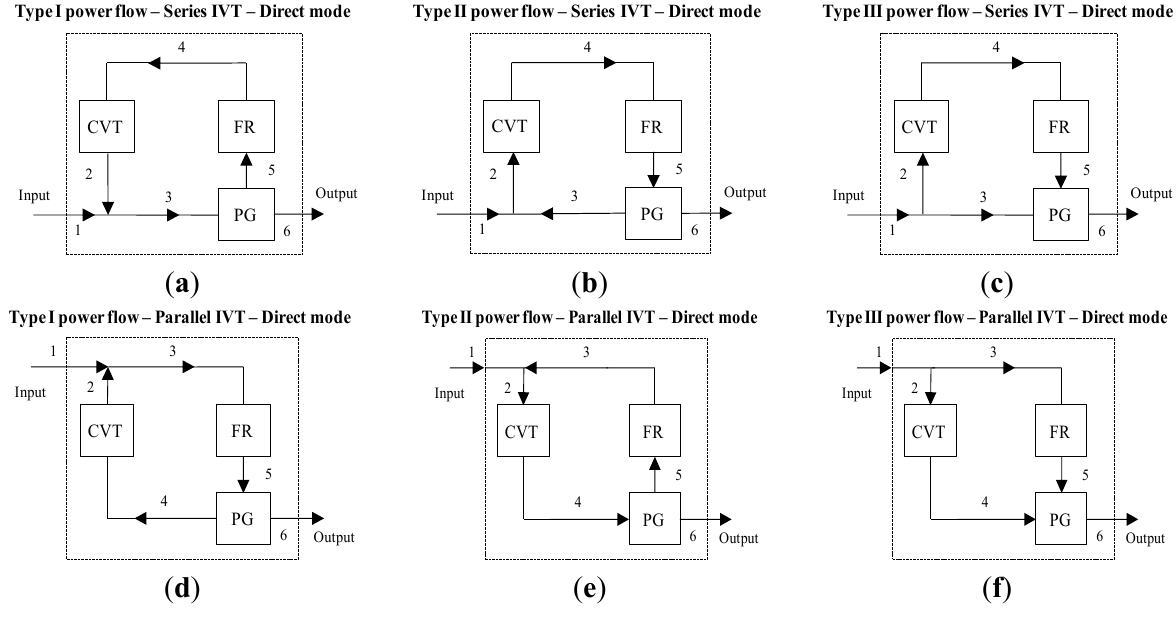
Figure 5. Classifications of the power flows in series and parallel IVTs. ( a – c ) Type I–III